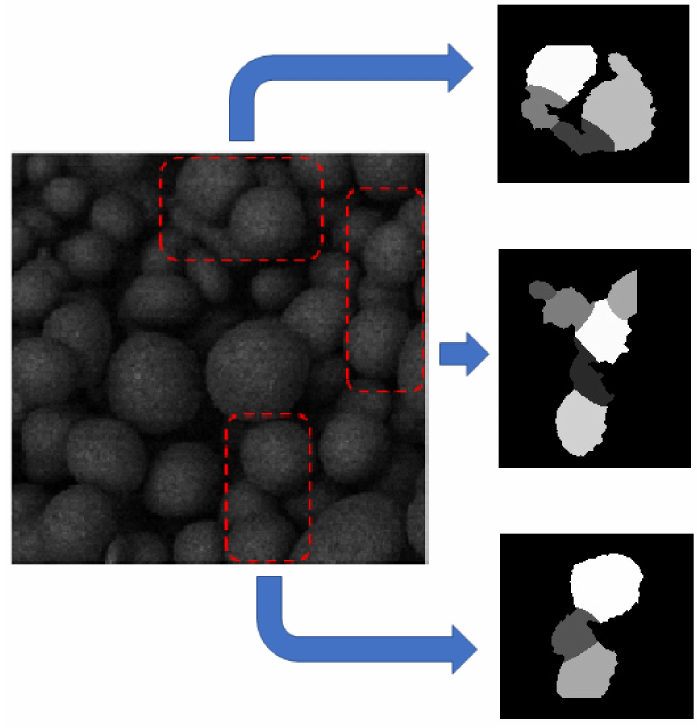
Figure 7. Overlapping pellet